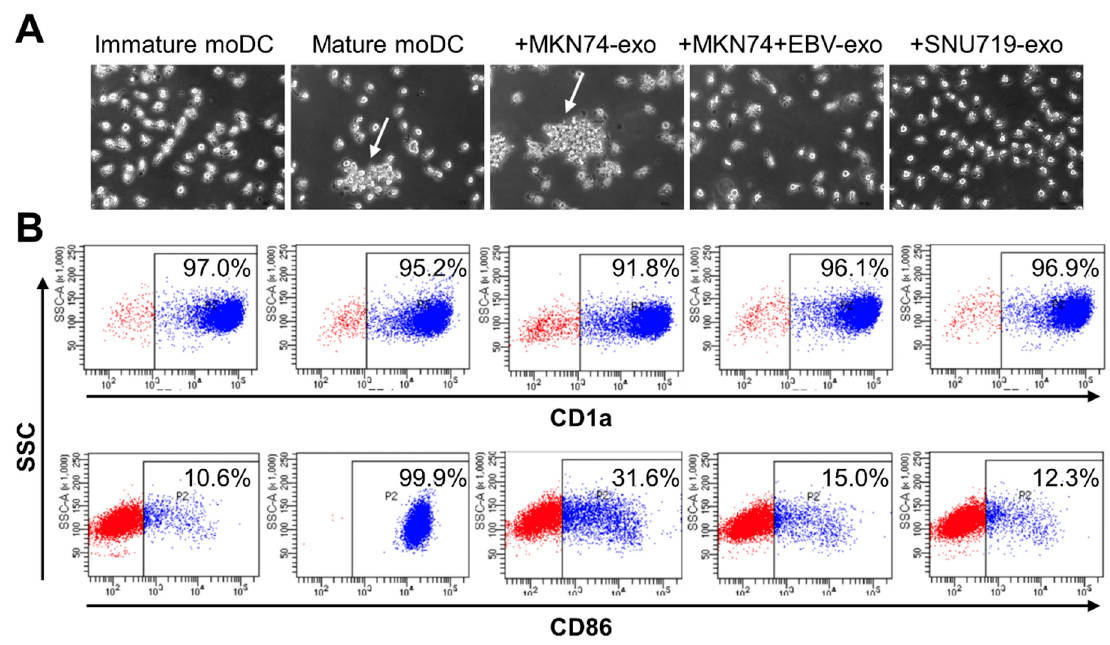
Figure 3. Differential effects of exosomes secreted by EBV-infected gastric cancer cells on the maturation phenotype of human monocyte-derived dendritic cells (moDCs). Immature DCs were either untreated or treated with the indicated exosomes or with LPS as a positive control for maturation. ( A ) Phase-contrast images of moDCs cultured with exosomes in EBV-infected cells. Large aggregates of cells (arrows) as reported for mature moDCs were found in MKN74-derived exome-treated moDCs but not in EBV-positive cell-derived exosome-treated cells. ( B ) Flow cytometry results of CD1a and CD86 on moDCs incubated with the indicated exosomes. The data are presented as % positive cells of indicated markers. The results are representative of three independent experiments from different donors.